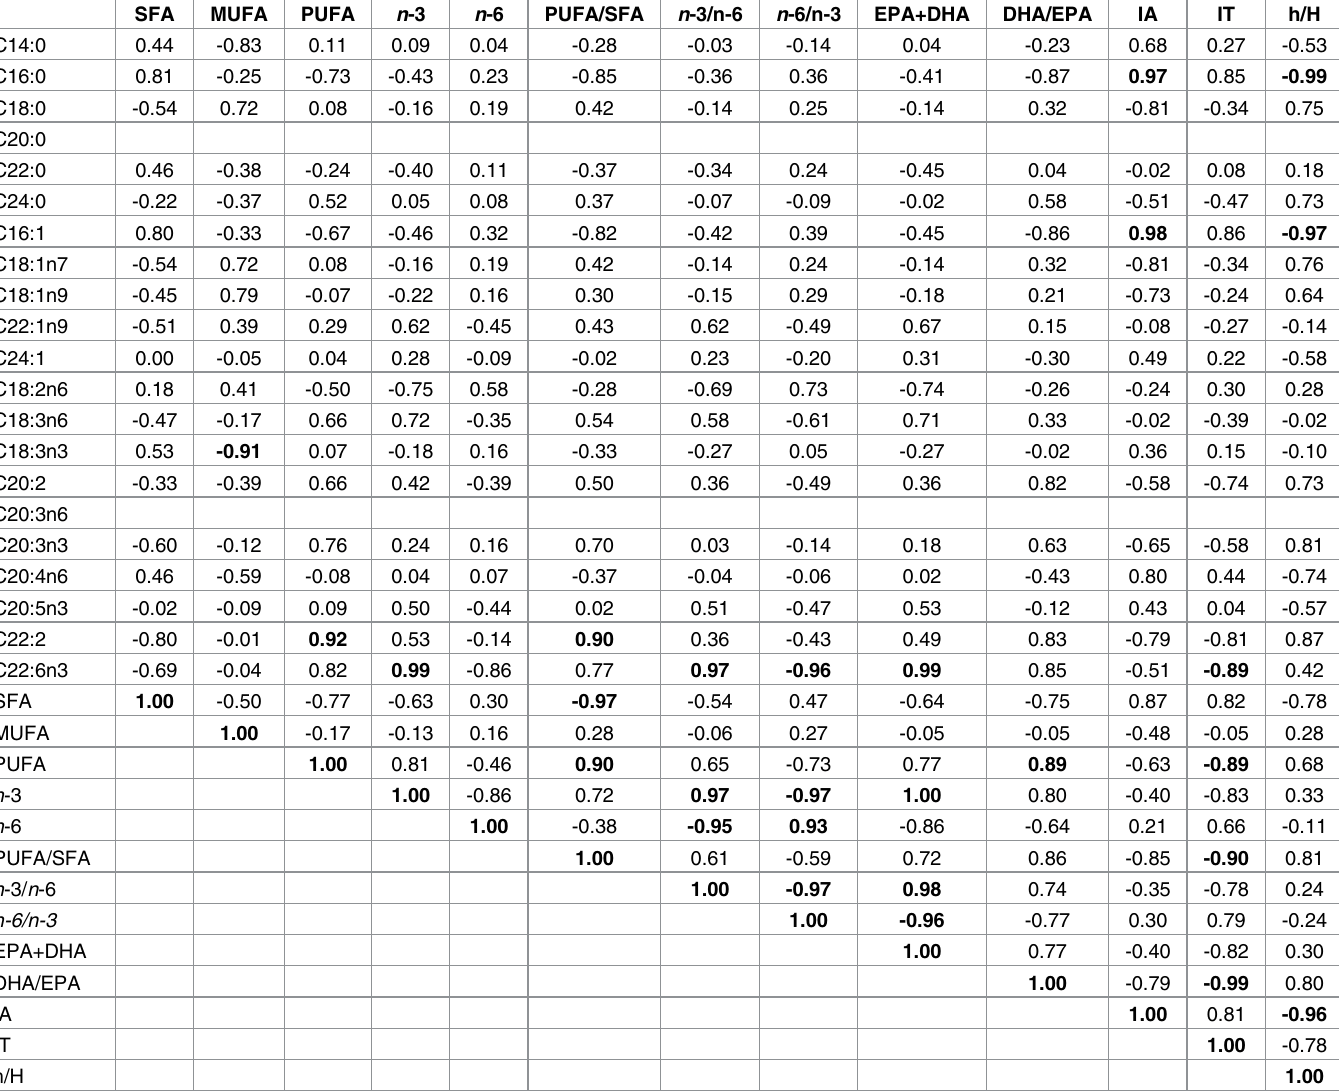
Table 3. Results of Pearson’s correlation test among the specific FA, total FAs and NQI of five Brazilian freshwater fish